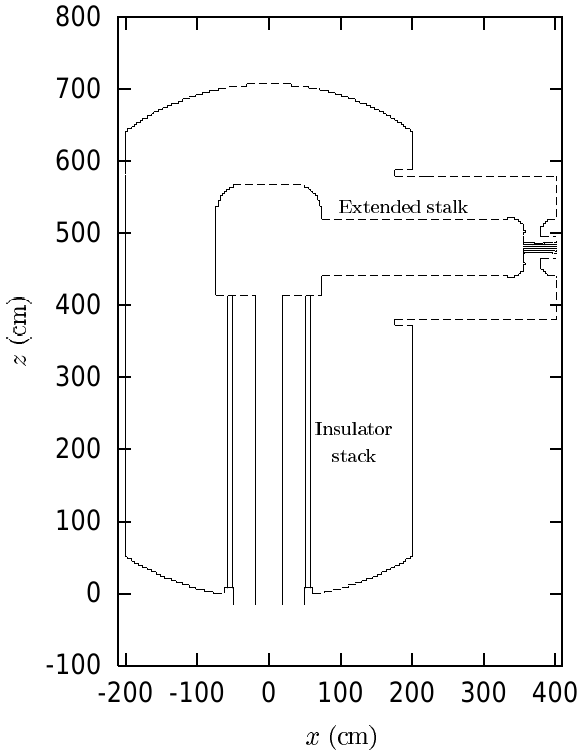
FIG. 6. Extended cathode stalk to reduce diode asymmetry (based on an earlier design than that in Fig. 1).